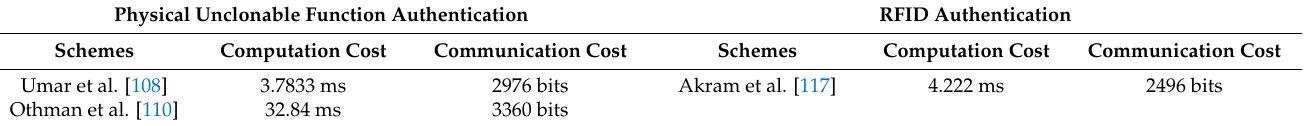
Table 21. Performance comparison of hardware-based (PUFs vs RFID)